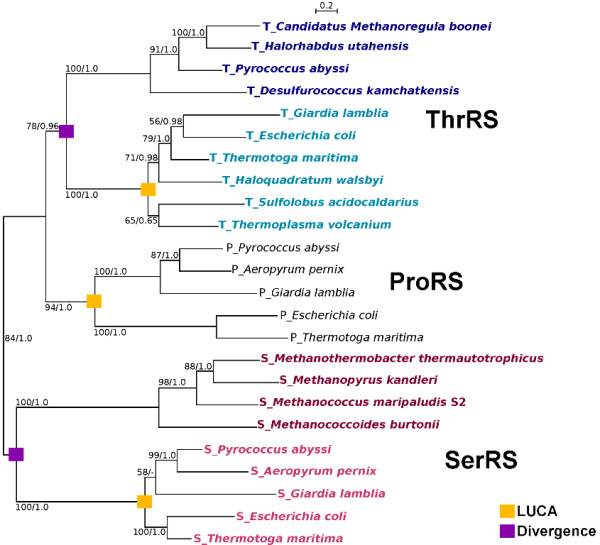
Phylogenetic analyses of representative Class II aaRS showing the divergence of the two forms of ThrRS and SerRS. Taxa that contain the rare form of the enzymes ThrRS and SerRS are represented in dark blue and red, respectively. Those that possess the common form (i.e. they are found across the three domains of life) are represented in light blue and pink.